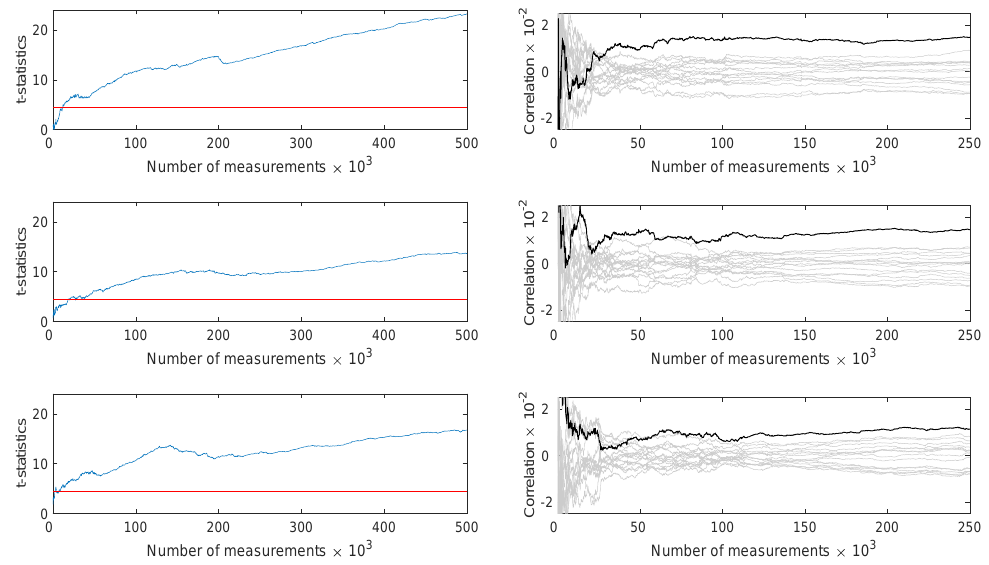
Figure 11: Non-specific t -test and CPA results on static power measurements from the second sample of the 65 nm ASIC after 0, 4 and 8 weeks of aging (top to bottom). The CPA targets a key nibble in the first round using the HW of the S-box